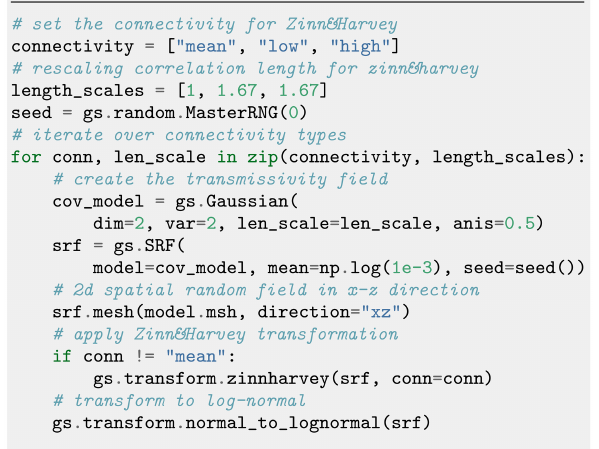
Figure 23. Generating correlated log-normal SRFs adapted to the mesh settings of the numerical model for three connectivity struc- tures following the Zinn and Harvey (2003) transformation.